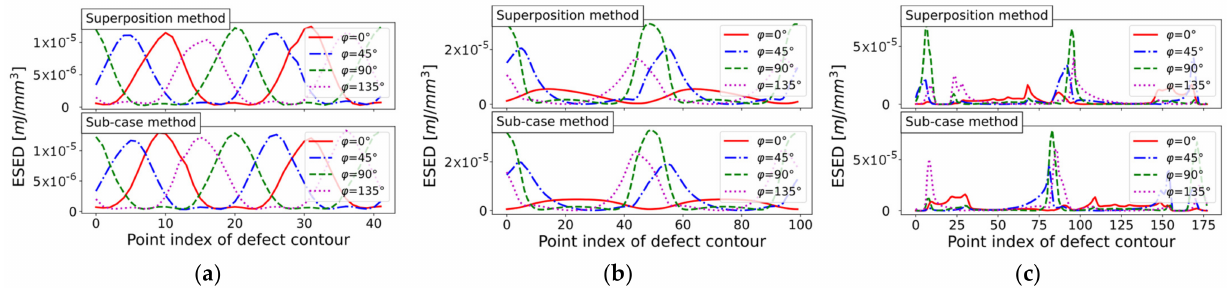
Figure 27. ESED course for three defect geometries, evaluated as sharp notch and with incremental load step of ∆ ϕ = 10 ◦ : ( a ) Circular hole-in-plate (mesh ‘circle_lin_R1mm_v1’); ( b ) Elliptical hole-in- plate (mesh ‘ellipsis_lin_rot0deg_v1’); and ( c ) Elongated defect (mesh ‘defect_elongated_lin_v1’).